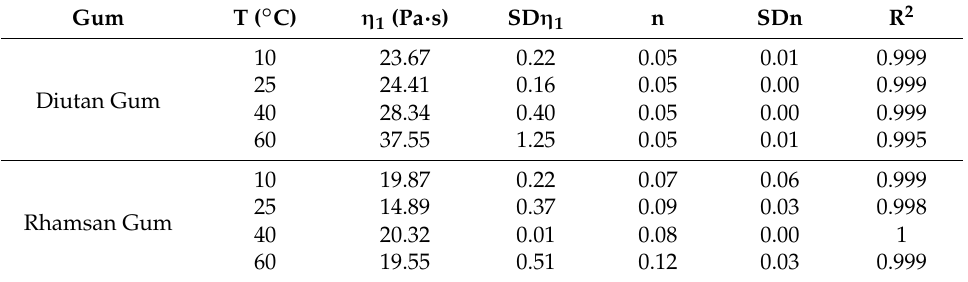
Table 2. Fitting parameter to Ostwald–Waele model for aqueous solutions of diutan gum and rhamsan gum. SD is standard deviation of the mean (n = 3) for η 1 and n.